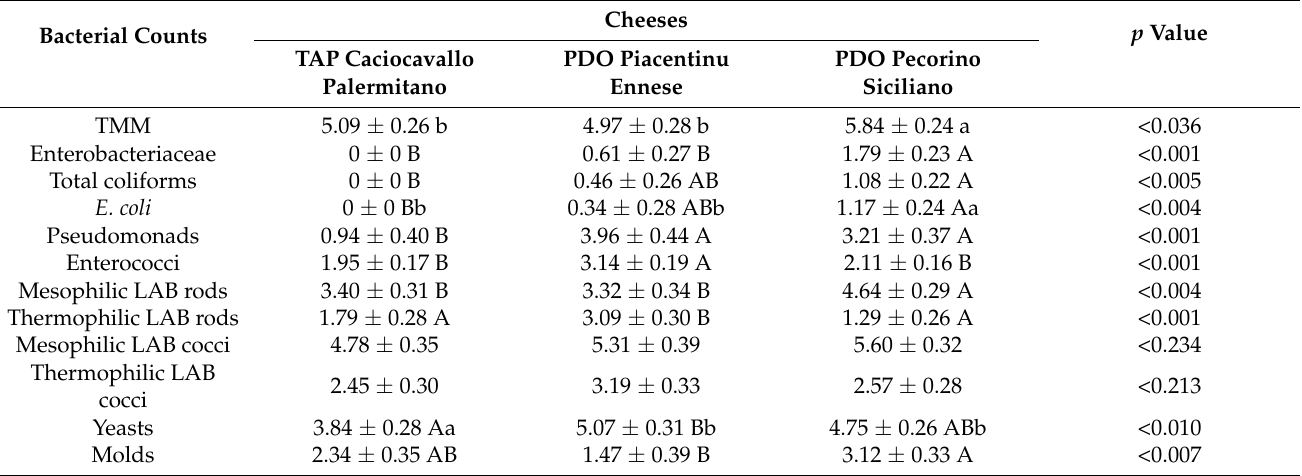
Table 1. Microbial loads (LSM ± s.e.) of the biofilms developed on the wooden shelves used to ripen traditional Sicilian